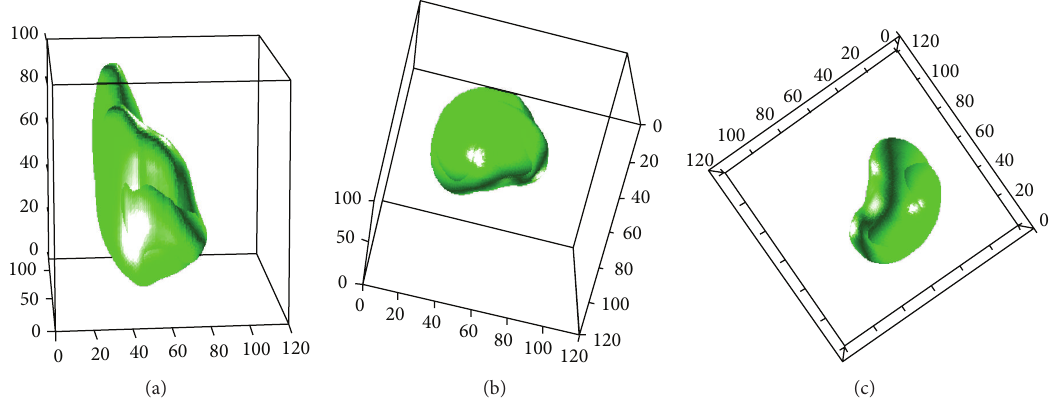
Figure 9: 3D visualization of segmentation results: (a) axial view, (b) coronal view, and (c) sagital view.